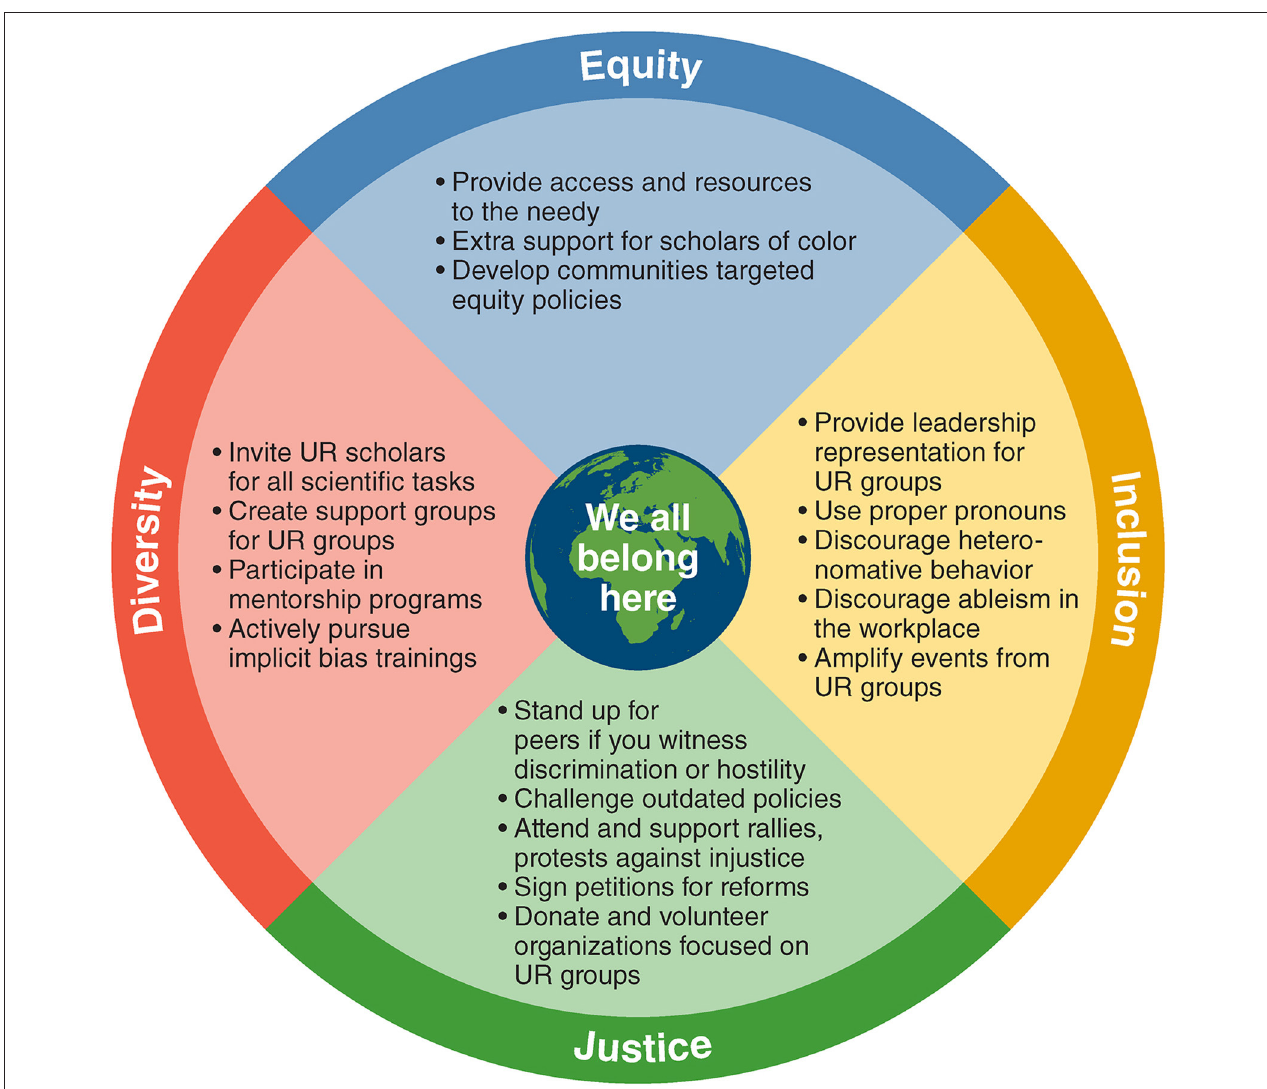
FIGURE 2 | How can we be part of the